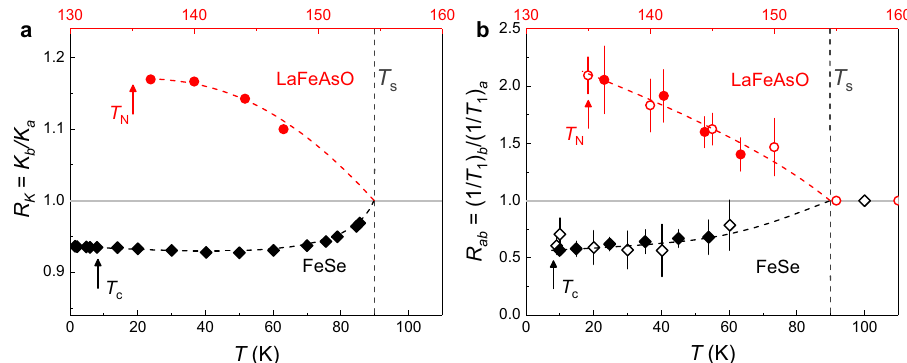
Fig. 2 Knight-shift and T 1 anisotropies in the nematic state. Temperature dependence of in-plane Knight-shift anisotropy ratio K b / K a ( a ) and in- plane 1/ T 1 anisotropy R ab ¼ ð 1 = T 1 Þ b = ð 1 = T 1 Þ a ( b ). Our data (solid symbols) are fully consistent with refs 13,55 (open symbols), but because we detwinned the crystals, our data are able to unambiguously identify the a and b axes. Dotted lines are guides to the eye. Error bars in a are smaller than the symbol size. Error bars in b correspond to s.d. in fi ts of the recovery of the nuclear magnetization after a saturating